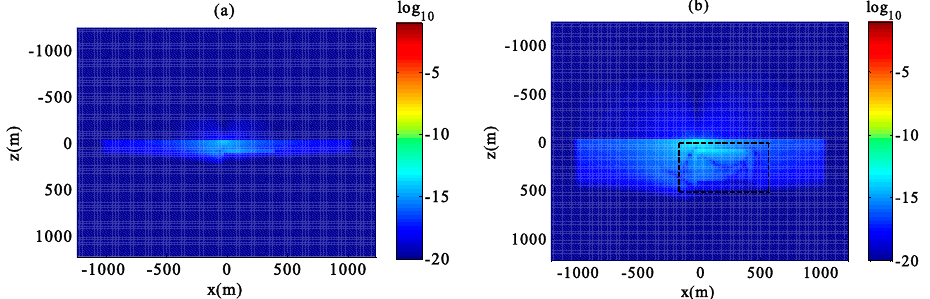
Figure 10. The snapshots of the induced current system in the fictitious wave field ( a ) early time; ( b ) late time.